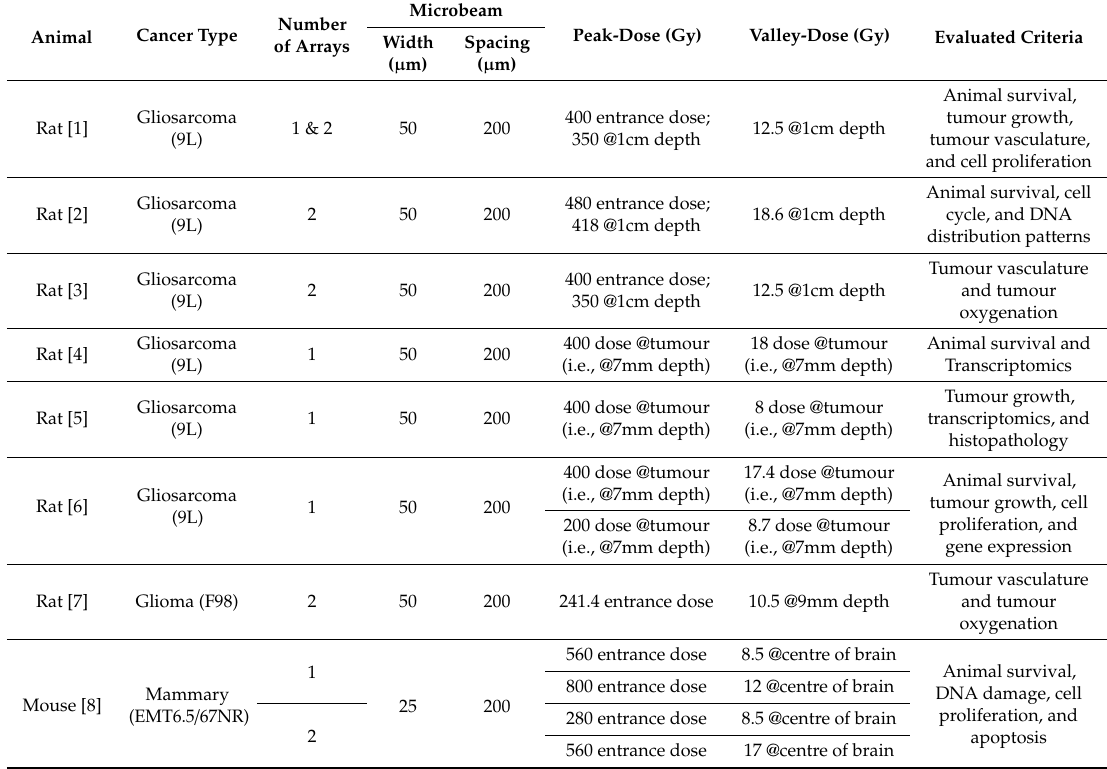
Table 1. MRT Parameters Used in Cancer